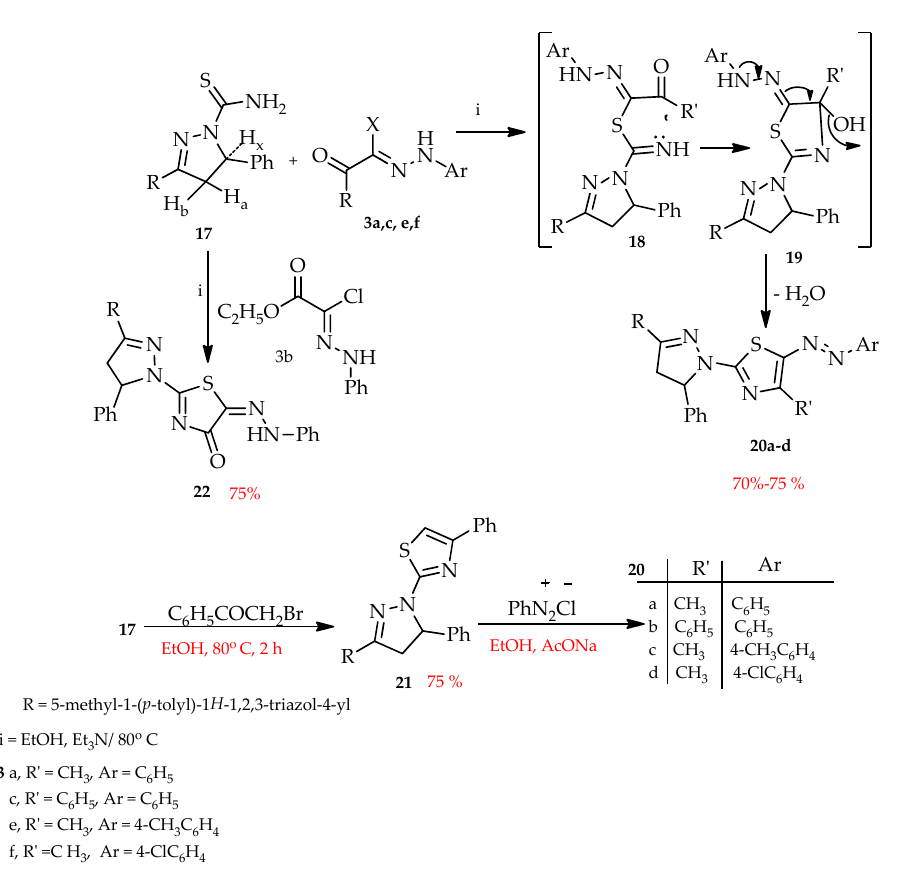
Scheme 3. Synthesis of thiazolone 14a – d .